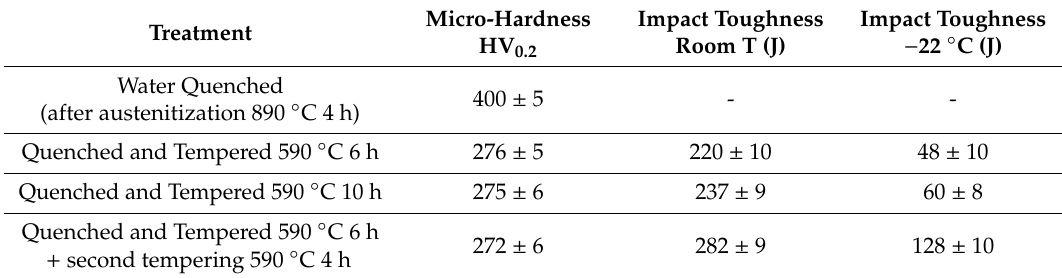
Table 2. Micro-Hardness and Impact Toughness of the forged S690 steel after di ff erent heat